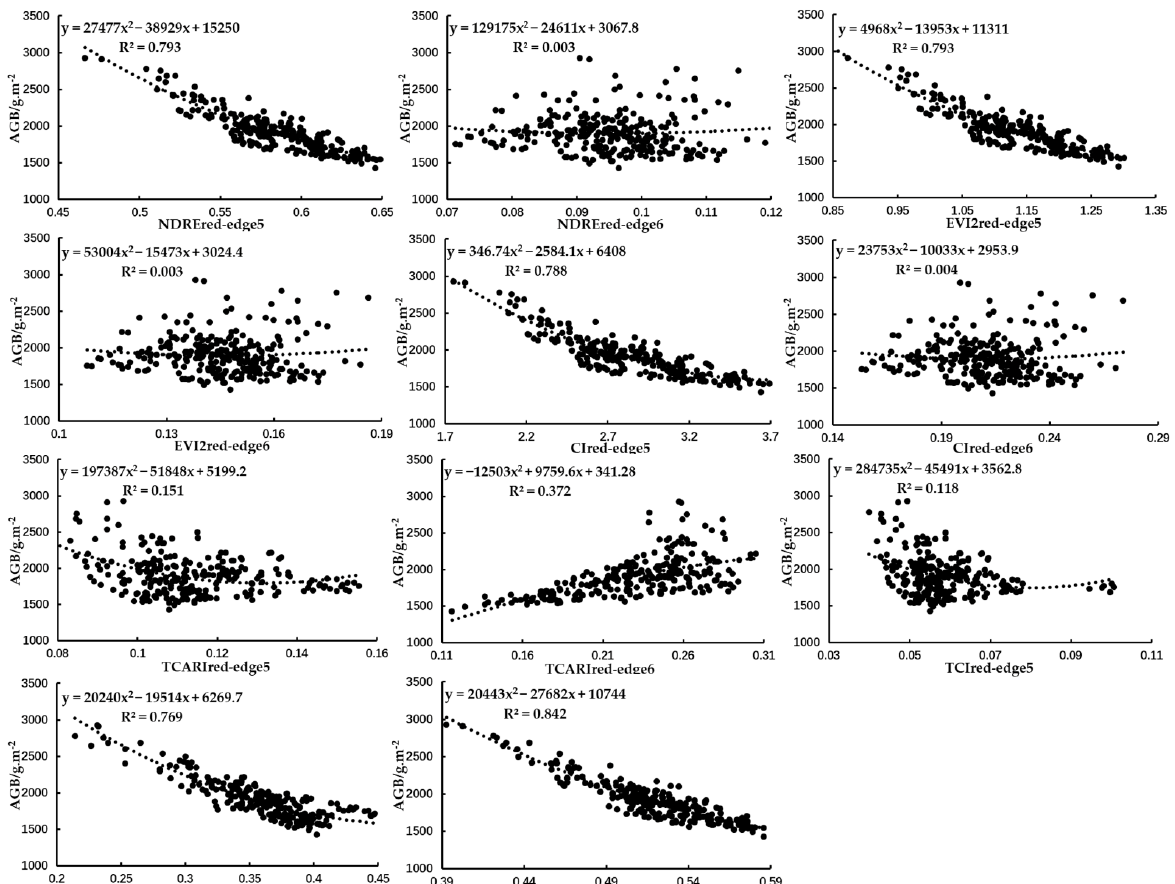
Figure 15. The fitting results of measured AGB and estimated AGB based on the partial least squares regression (PLSR) model.